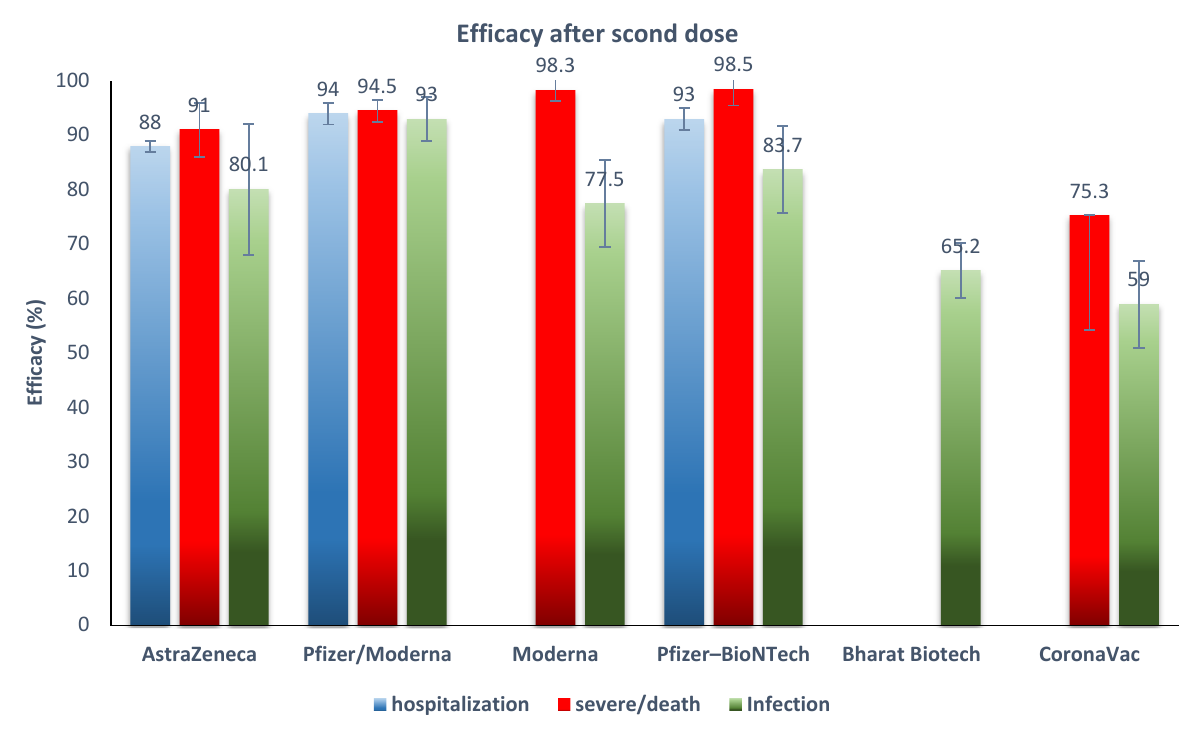
Figure 4. Effectiveness of COVID-19 vaccines after the second dose against Delta variant infection, hospitalization, and severe infection or death. * Reported for mRNA vaccines (Pfizer/Moderna).